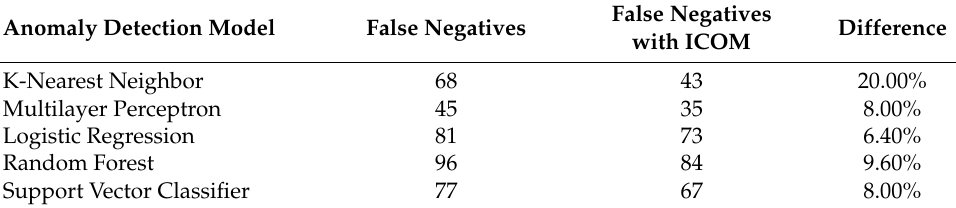
Table 8. Anomaly detection models to detect malicious